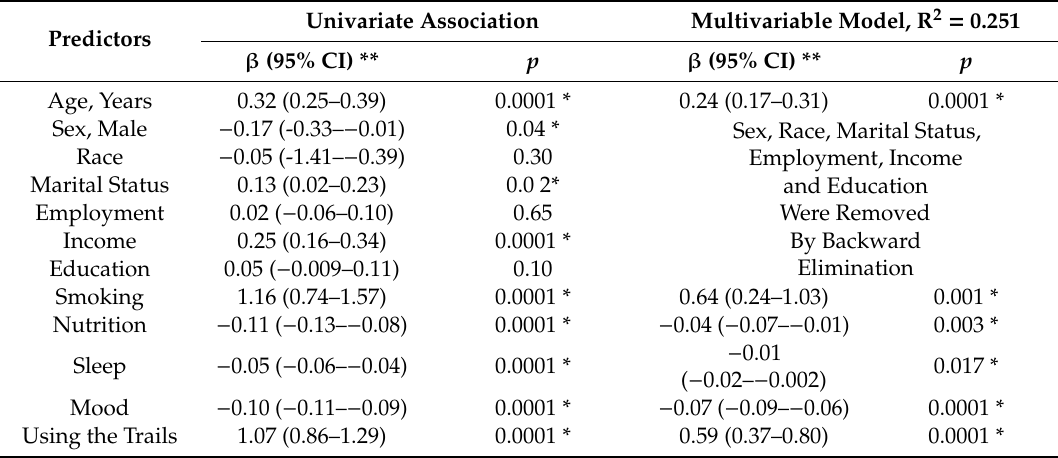
Table 7. Backward linear regression analysis showing univariable and significant multivariable associations of predictors of self-rated wellness and health. The dependent variable was self-rated wellness and health index. All other variables were considered as independent